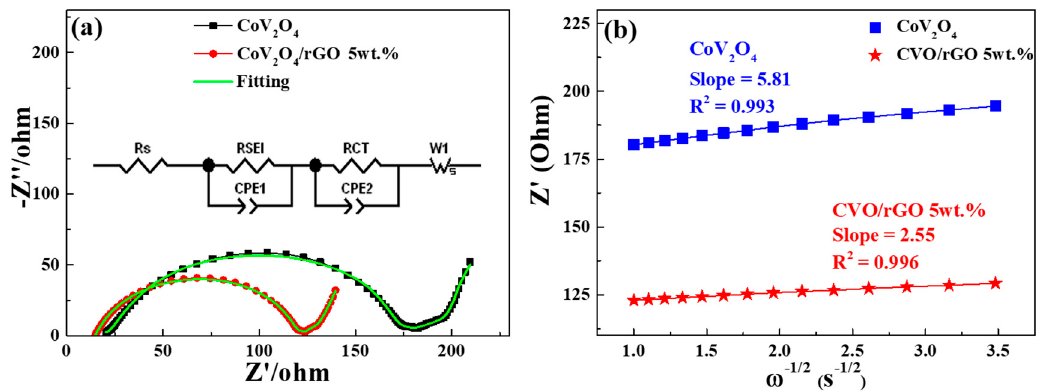
Figure 6. ( a ) Electrochemical impedance spectra (Nyquist plots); inset: the equivalent circuit used to fit the EIS; and ( b ) the liner fit of the relationship between Z ′ and ω − 1 / 2 at low frequencies of the bare CoV 2 O 4 and rGO-wrapped CoV 2 O 4 electrodes. Table 1. Impedance parameters and di ff usion coe ffi cients of the equivalent circuit.